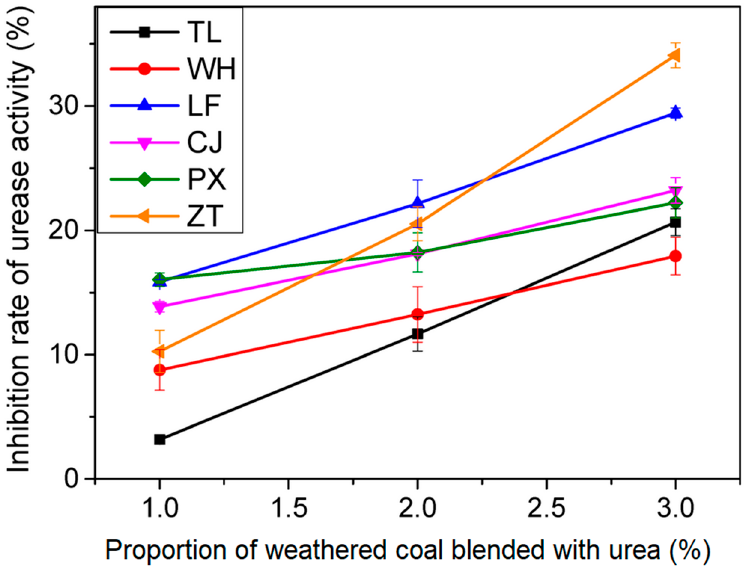
Figure 3. Inhibition rate of urease activity when different proportions of weathered coal from dif- ferent geographical locations were blended into urea.